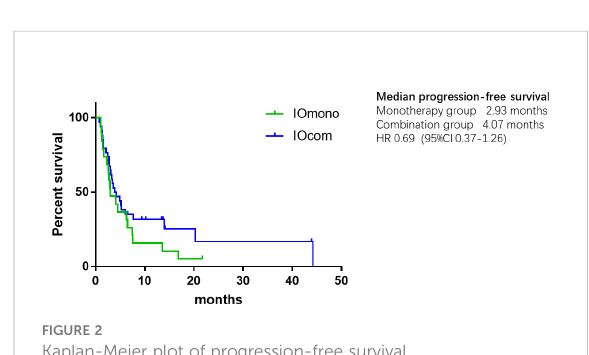
FIGURE 2 Kaplan-Meier plot of progression-free survival.